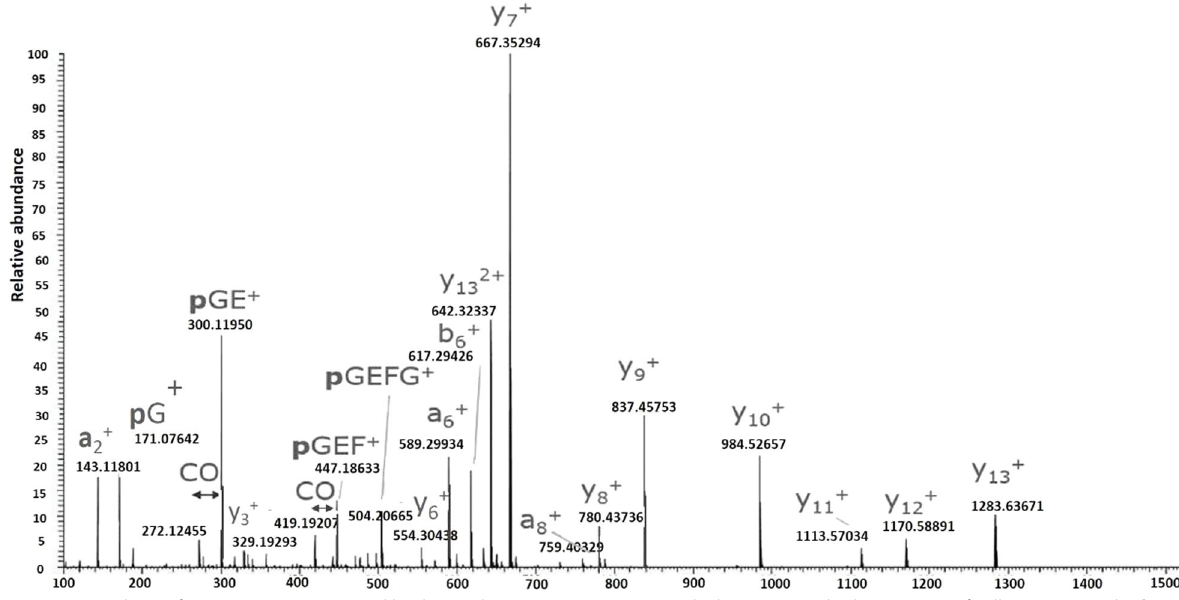
Fig. 4 Internal pG fragments are represented by the product ions at m/z 171.076, which are extremely characteristic of collagens. Internal a , b , + and Ɣ ions were the most commonly observed pieces. Kleinnijenhuis et al. (2018) Copyright (2018) with permission from